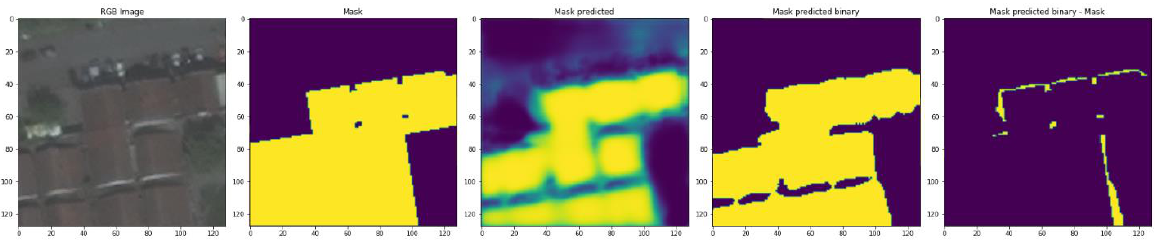
Figure 17. Corrected errors in the input data.